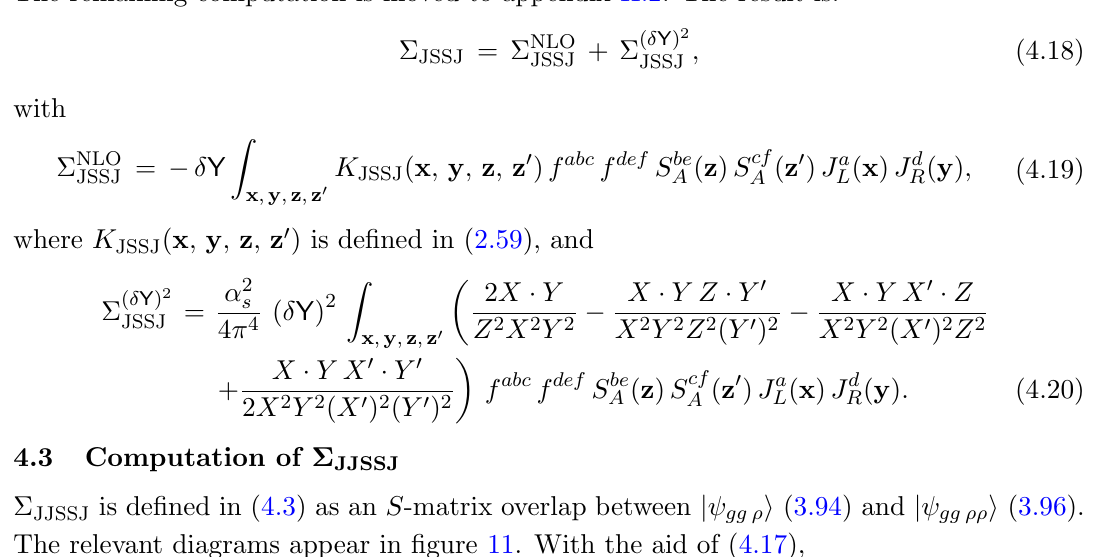
Figure 11 . The diagrams for (cid:6) JJSSJ . E(cid:11)ective two gluon emission vertex corresponds to j gg (cid:26) i . The remaining computation is moved to appendix H.2. The result